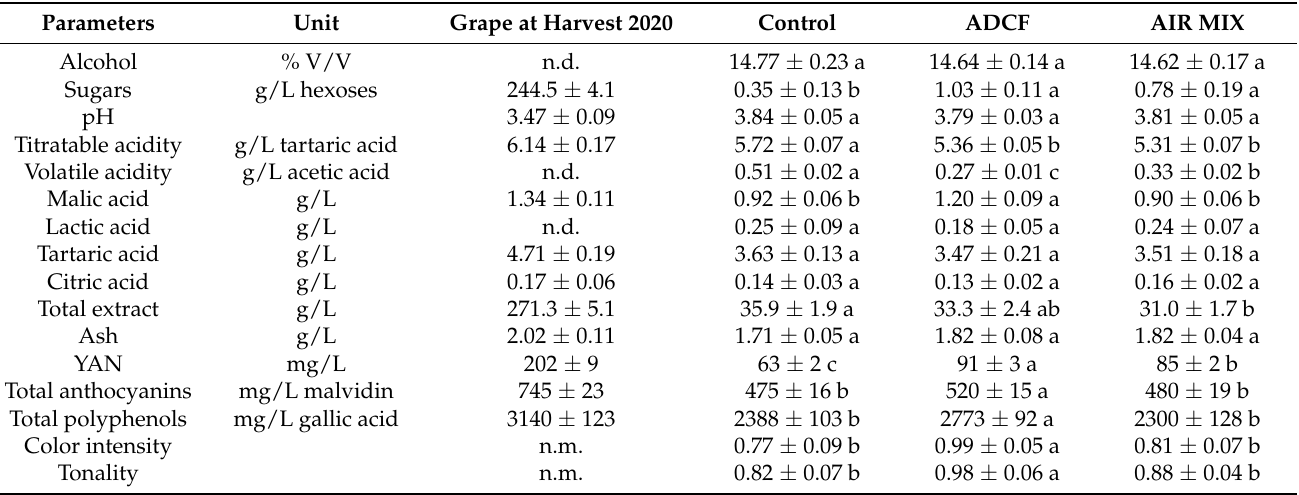
Table 1. Eno-chemical characteristics of Cabernet Sauvignon grape at harvest and the three wines at the racking for the 2020 year. The data are expressed as mean ( ± SD) of three set of berries at harvest and three 500 mL bottles, each one taken immediately after wine mixing in the tank. Different letters in a row for the wine comparison indicate statistically different data (Tukey, p ≤ 0.05). n.d., not detected; n.m., not measured.